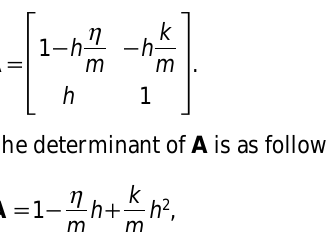
Table 2 is calculated in the same way as when h (cid:2) 0.